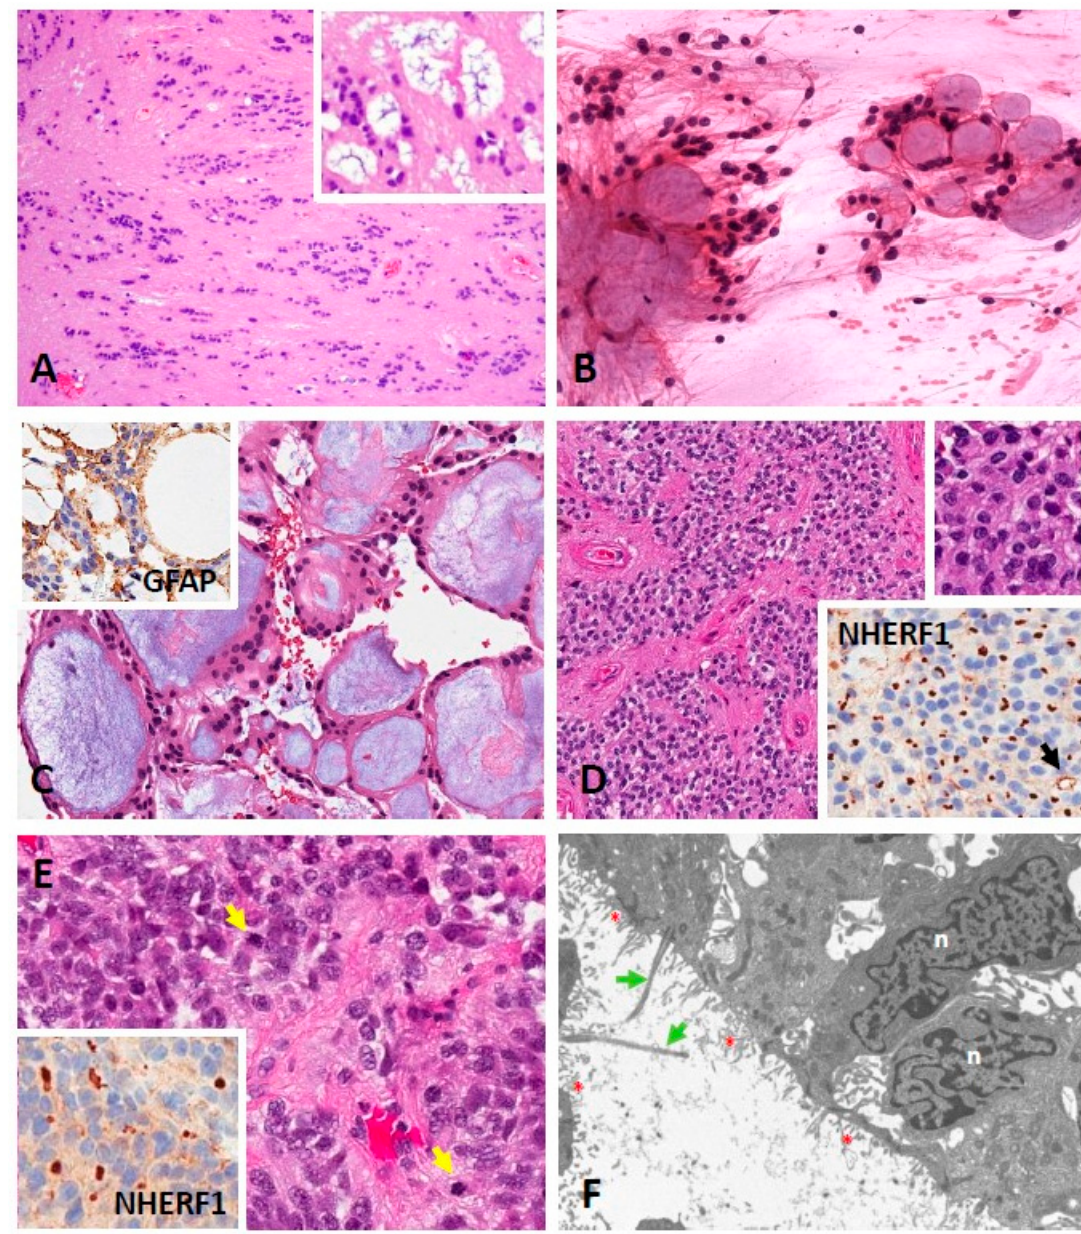
Figure 2. Morphology of subependymoma and ependymoma. ( A ) Subependymoma composed of clusters of isomorphic nuclei embedded in a fibrillary matrix of glial cell processes (HE, 100 × ). Cystic degeneration and nuclear pleomorphism (degeneration-related) can be present in larger tumors (inset) (HE, 200 × ). ( B) Myxopapillary ependymoma showing ependymal cells with bland oval nuclei and fibrillary processes around aggregates of myxoid material (smear, HE, 200 × ). ( C ) Tissue section of myxopapillary ependymoma showing bland GFAP positive (inset, GFAP, 200 × ) ependymal cells around blood vessels with myxoid degeneration (HE, 200 × ). ( D ) Ependymoma composed of neoplastic glial cells arranged around blood vessels in pseudorosettes (HE, 100 × ). The tumor nuclei are round to oval, monomorphic with stippled chromatin (top inset) (HE, 200 × ). Anti-NHERF1/EBP50 immunohistochemistry showing numerous dot-like microlumens and a rare ring-like structure (arrow) (bottom inset) (200 × ). ( E ) Anaplastic ependymoma with enlarged pleomorphic nuclei and mitotic activity (arrows) (HE, 200 × ). Anti-NHERF1/EBP50 immunohistochemistry showing an area with microlumens (inset) (200 × ). ( F ) Electron micrograph showing the lumen of a true rosette lined by ependymal tumor cells with rare cilia (green arrows) and abundant microvilli (red asterisks) (18,000 × ). Abbreviations: HE—hematoxylin and eosin, n—nucleus Note: Photographs in D-F were kindly provided by Dr. Maria-Magdalena Georgescu, NeuroMarkers PLLC, Houston, TX,